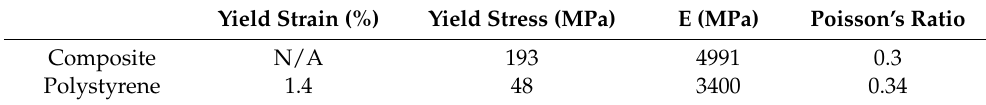
Table 2. Material properties for composite and polystyrene sockets used in the numerical simulation. Yield Strain (%) Yield Stress (MPa)